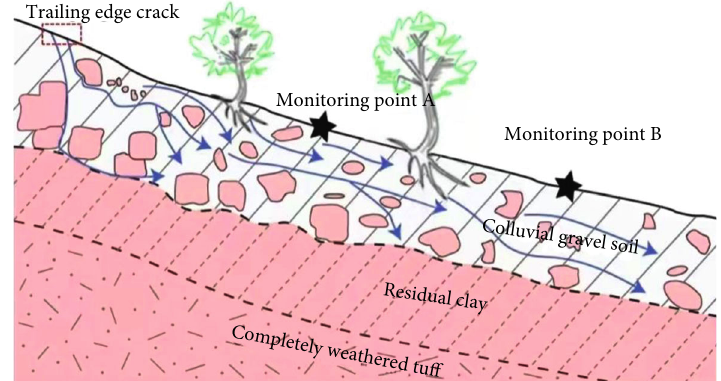
Figure 11: Groundwater dominant channels in the study area (adapted from [19]).